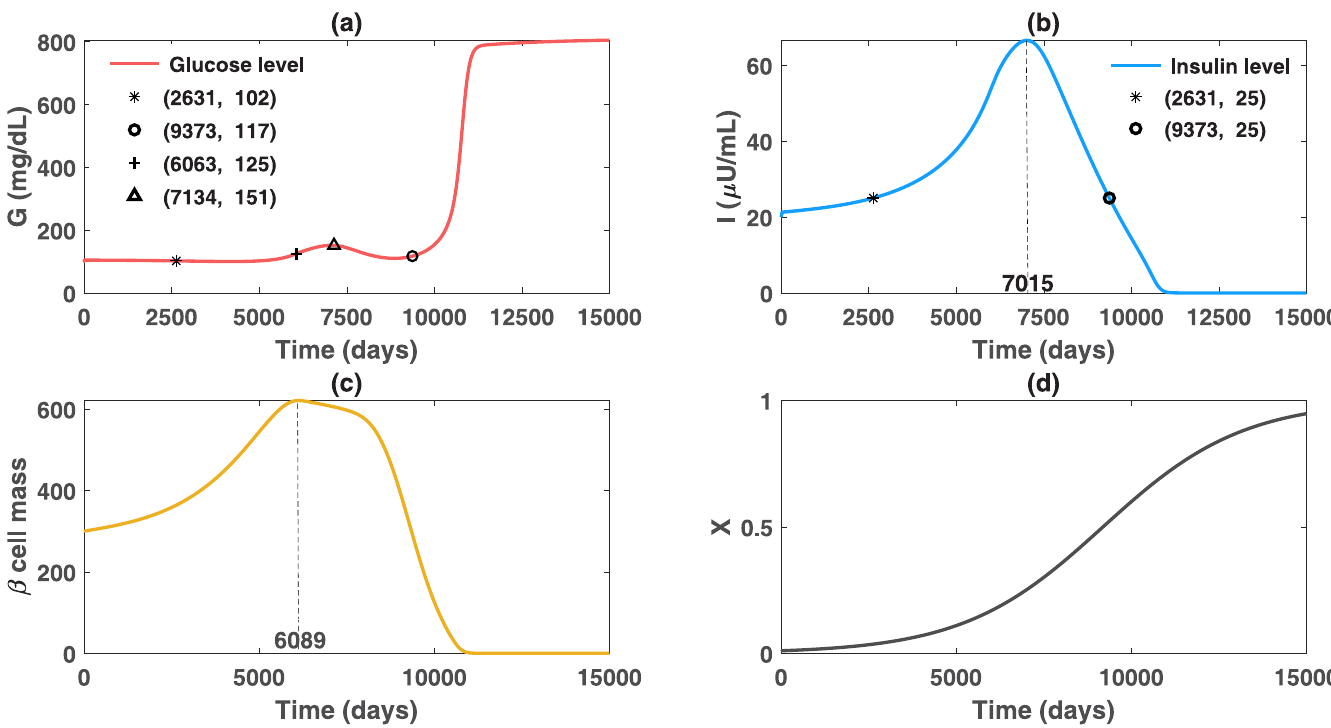
Fig 2. Dynamics of glucose, insulin and functional beta-cell mass level for patient A with severe obesity ( X approaches 1 progressively). This figure depicts the impact of severe obesity on the glucose regulatory system. The pathogenic factor X initially overstimulates the beta-cell function of this patient. The insulin level exceeds 25 μ U/ml after day 2631, which represents the onset of hyperinsulinemia. However, at this time, the glucose level is 102 mg/dl, which is close to normal. As X continuously increases, the functional beta-cell mass keeps rising before day 6089 and then decreases afterwards. Correspondingly, the insulin level retains increasing before day 7015 and then descends. The hyperinsulinemic stage ends after day 9373 and insulin deficiency gradually occurs afterwards. In the hyperinsulinemic stage, patient A experiences some fluctuations in the glucose levels. The glucose level exceeds the threshold of diabetic stage on day 6063, yet decreasing for a while after reaching the level 151 mg/dl on day 7134. Subsequent to the appearance of beta-cell failure and insulin deficiency, a sharp rise of the glucose level occurs, transitioning patient A to overt diabetes.